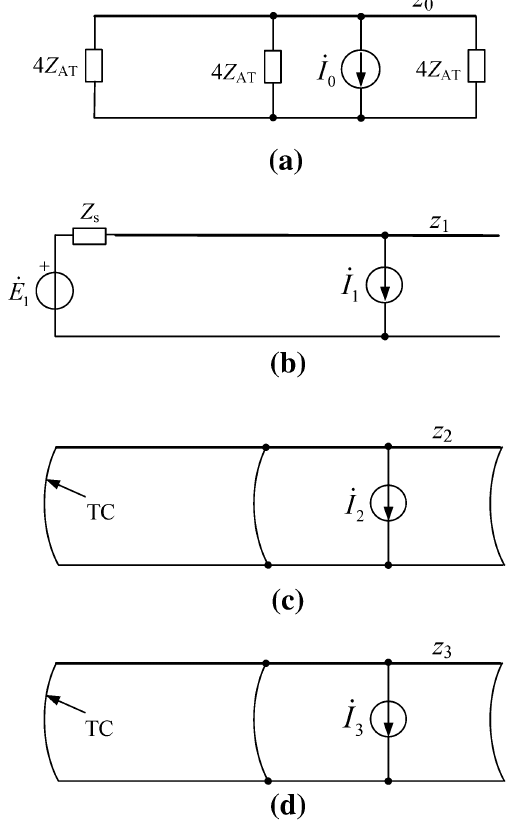
Fig. 2 Sequence networks of the double-track AT feeding system: a 0-sequence network; b 1-sequence network; c 2-sequence network; d 3-sequence